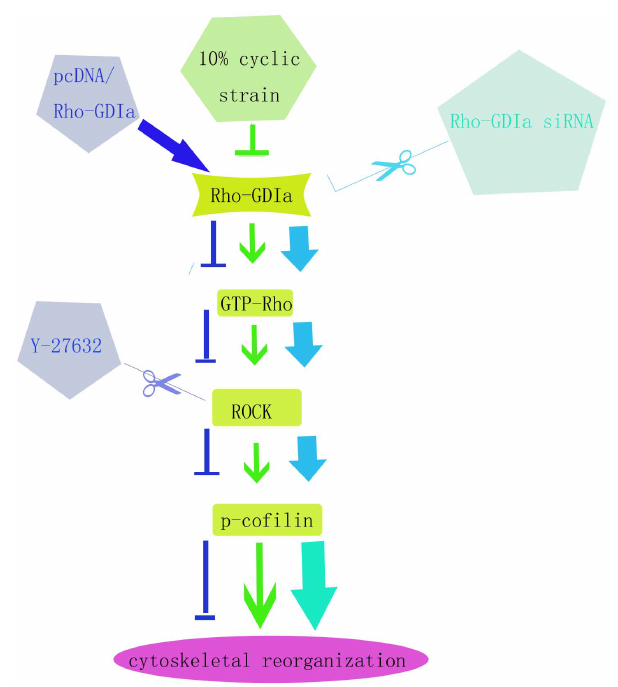
Figure 5. Schematic drawing outlining the pathway of the Rho- GDP dissociation inhibitor alpha, GTP-Rho, Rock and p-cofilin that mediates the enhancement of migration and cytoskeletal reorganization by cyclic strain treatment. Inhibitors and activators of each of the molecules in the pathway regulate the effect of cyclic strain on the member(s) downstream, but not upstream. These studies allow the determination of the hierarchical relationships among the signaling molecules shown in this